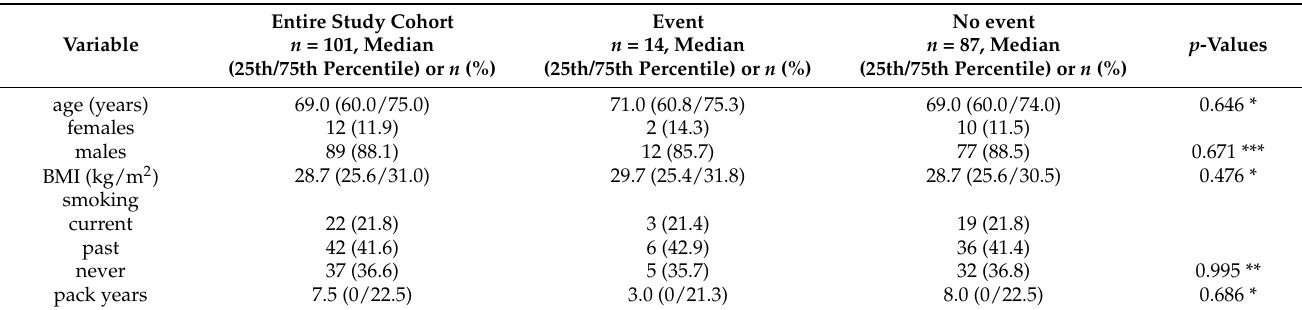
Table 1. Demographic variables in dependence of the occurrence of adverse cardiovascular events one year after CABG surgery.